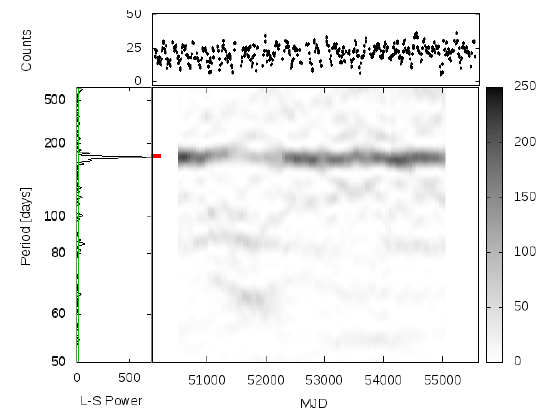
Figure 6: X1820-303.